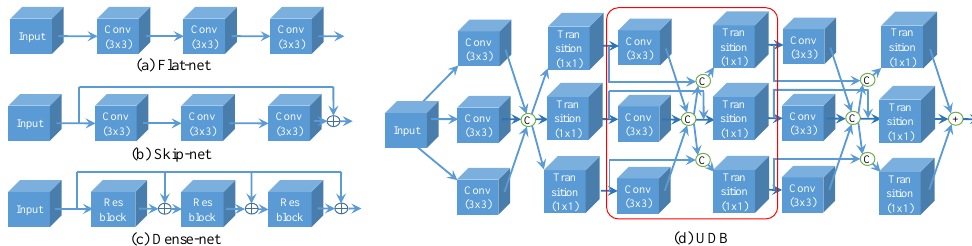
Figure 1. Frameworks of the CNN-based modules. ( a ) Flat-net (e.g., SRCNN [23] and FSRCNN [43]): Direct connections are commonly used to learn the features. ( b ) Skip-net (e.g., VDSR [24]) : An identity map with connecting input to the output is pioneered for SISR. ( c ) Dense-net (e.g., DenseNet [26] and SRDenseNet [27]): The feature maps are directly passed from the preceding layers to the current layers through the identity function with much richer connections. ( d ) UDB: Interacted multiple-path units are embedded for extracting local feature maps with a richer ultra-dense connections. “ C ” and “ + ” denote the concatenation and adding operation,